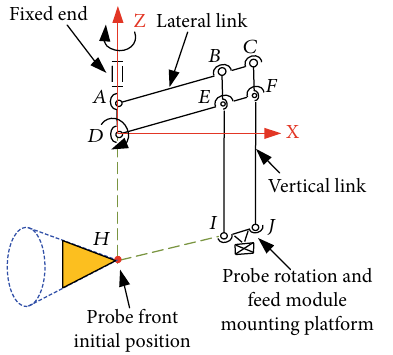
Figure 5: Schematic diagram of posture adjustment module.